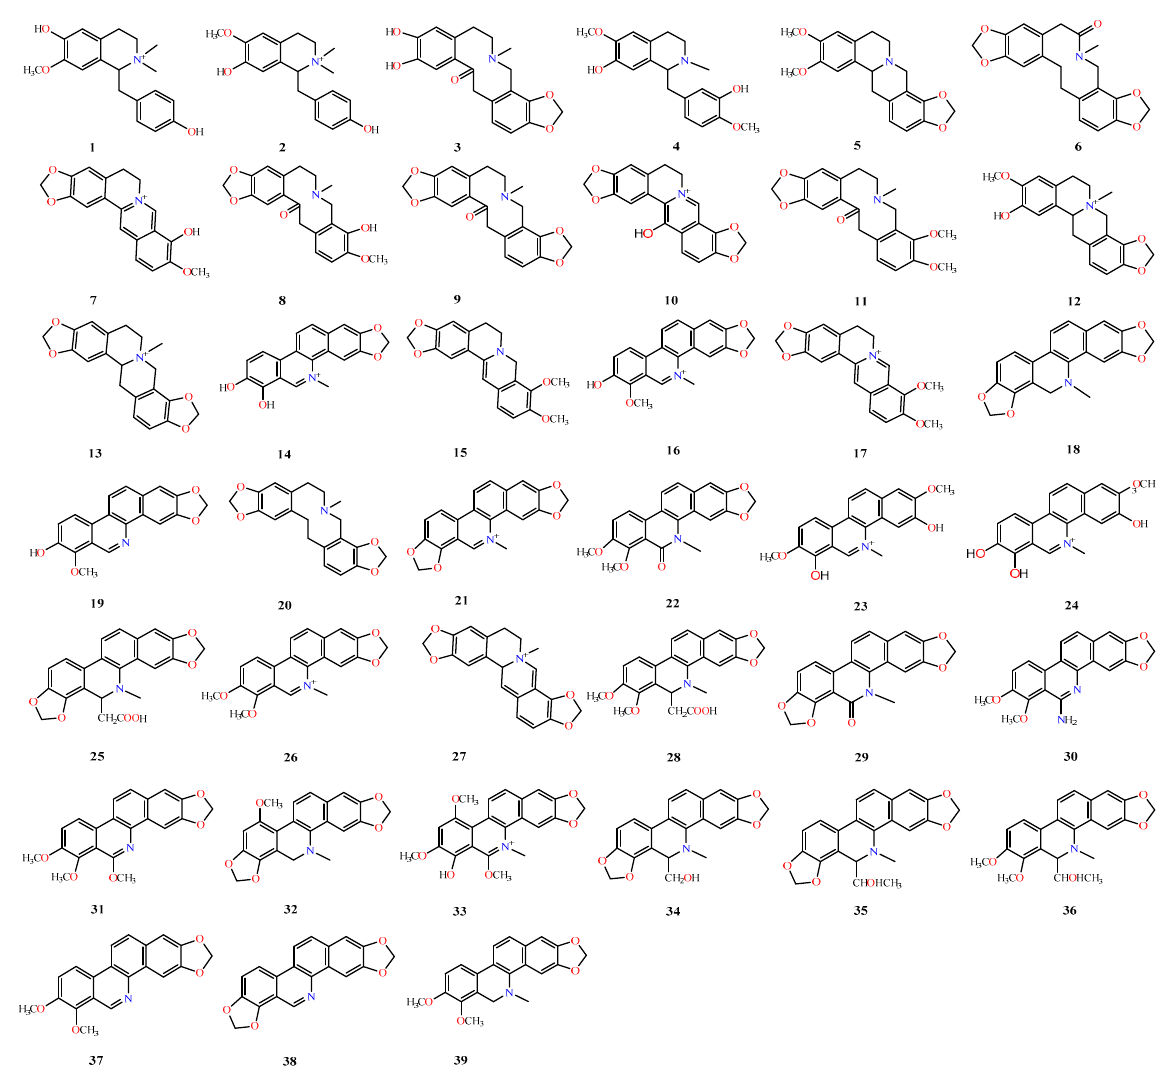
Figure 3. Structures of identified impurities from Bopu powder ® and Sangrovit ®